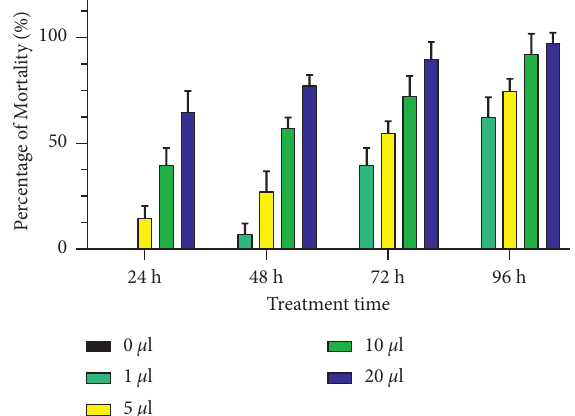
Figure 9: Mortality rate of Callosobruchus maculatus Fab. adults exposed to a contact test of Dittrichia viscosa L. essential oils.